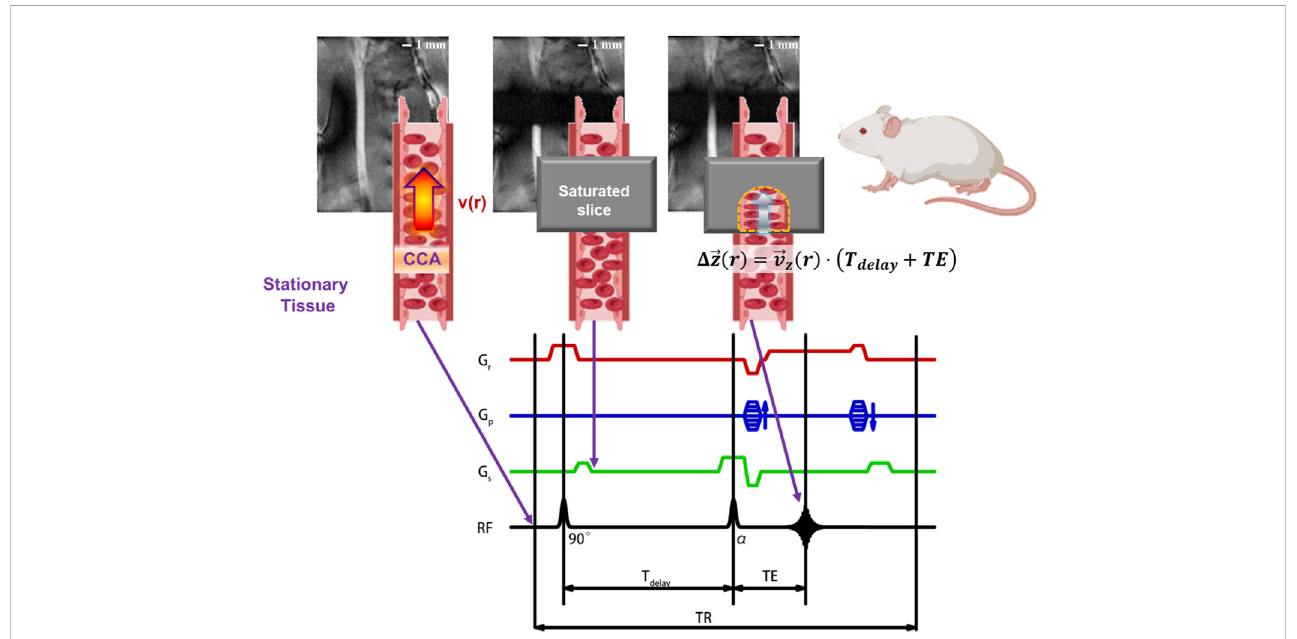
FIGURE 1 SchematicdiagramofLSDIappliedtotheleftcommoncarotidarteryofSDrats.Theessence oftheLSDImethodisthatthepartiallyoverlapofTOF-MRA and T 1 -weight FLASH in the fi eld of view, and the path of blood fl ow can be visualized by adjusting the delay time. This method performs a T 1 -weight FLASH scan outside the saturated slice to observe the vascular geometry upstream and downstream of the region of interest and ensures that the saturated slice is perpendicular to the blood vessel. At the same time, a TOF scan with a speci fi ed delay time is performed in the saturated slice to observe the displacement of the blood fl ow at different radial positions and eventually obtain the fl ow velocity